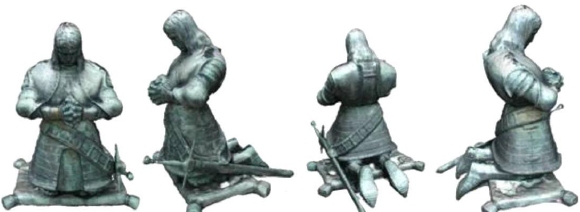
Figure 4. 3D-model based on Nikon D70 images (Arc3d)